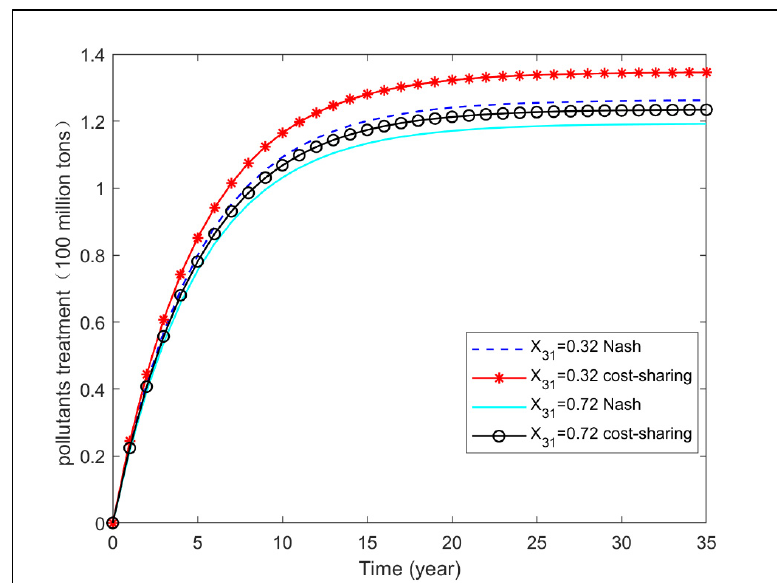
Figure 8. The effects of Shanxi province’s X 31 on pollutants treated.